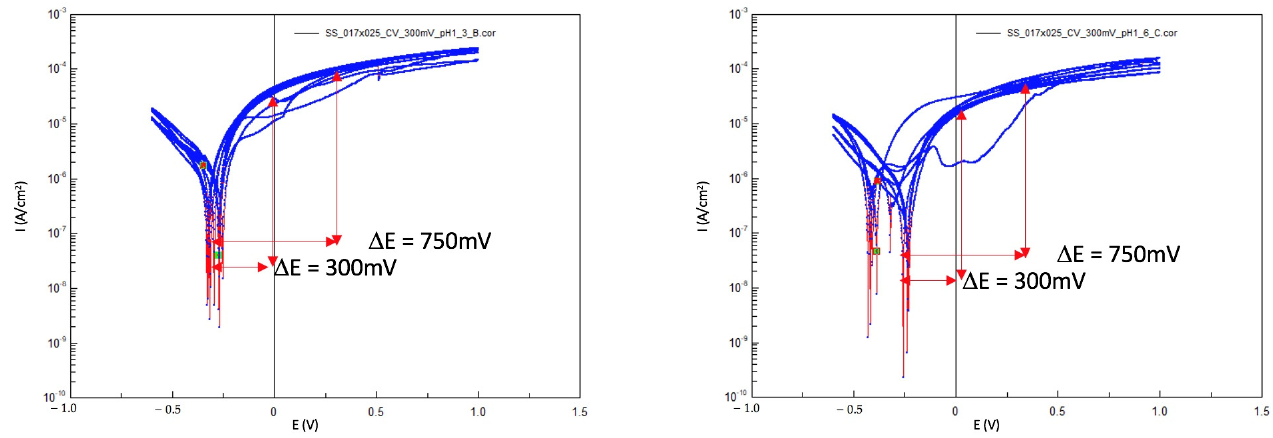
Figure 9. Two CV Log(i) versus E curves from two SS wires in Ringer’s solution pH = 1, RT; the positions for polarization are marked with red arrows.